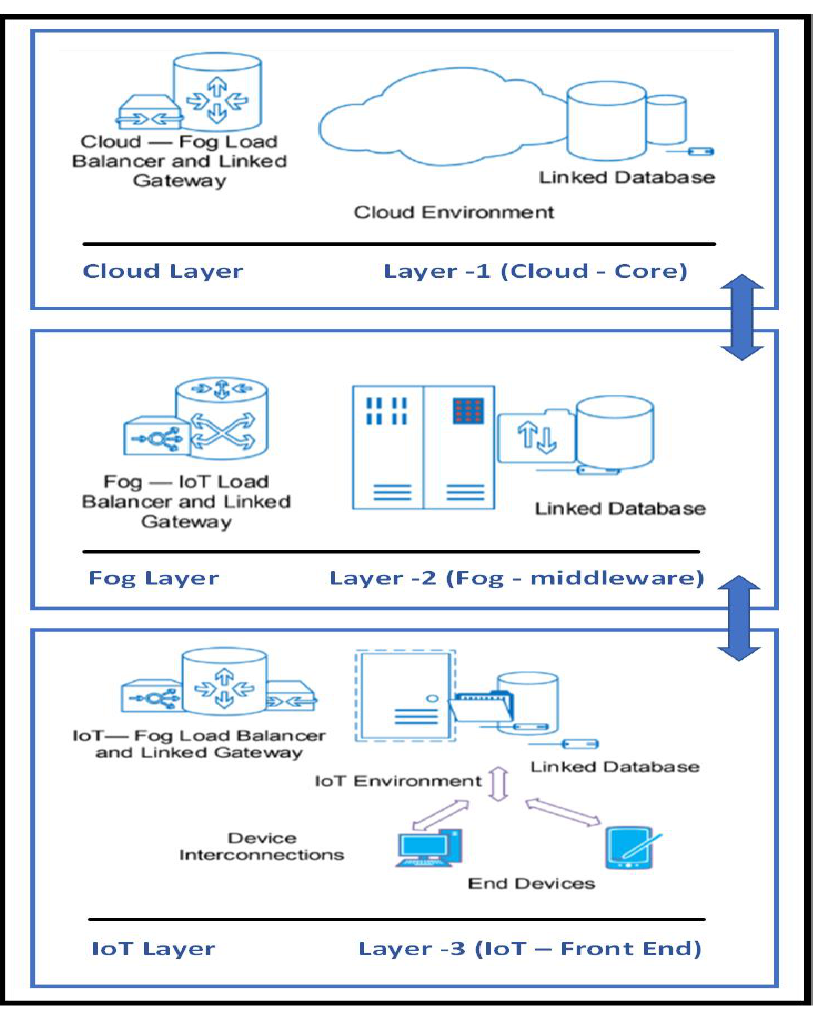
Figure 2. Fog-IoT